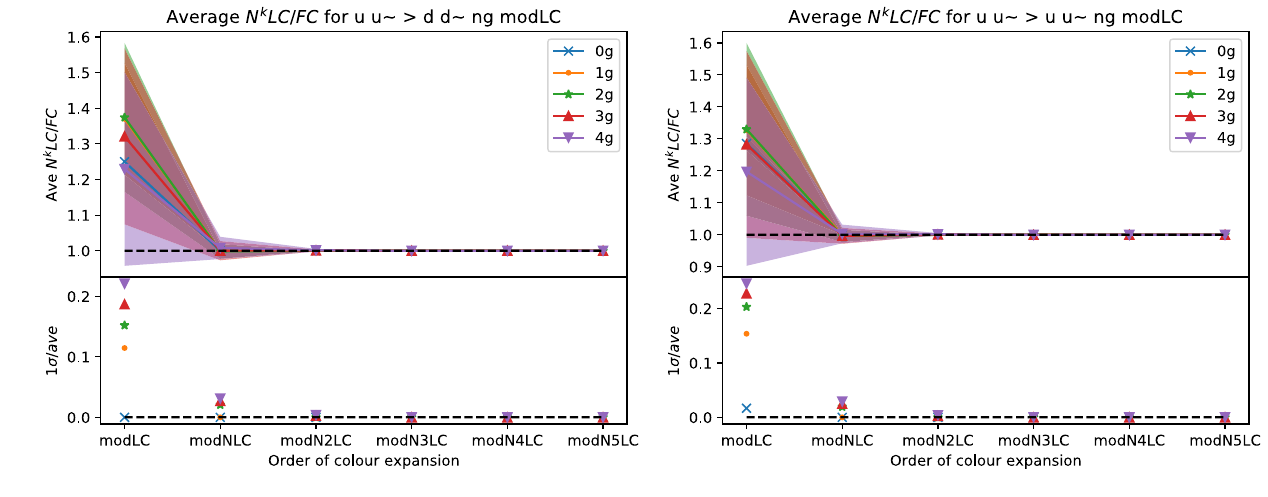
Fig. 18 Same as Fig. 5 but at modified